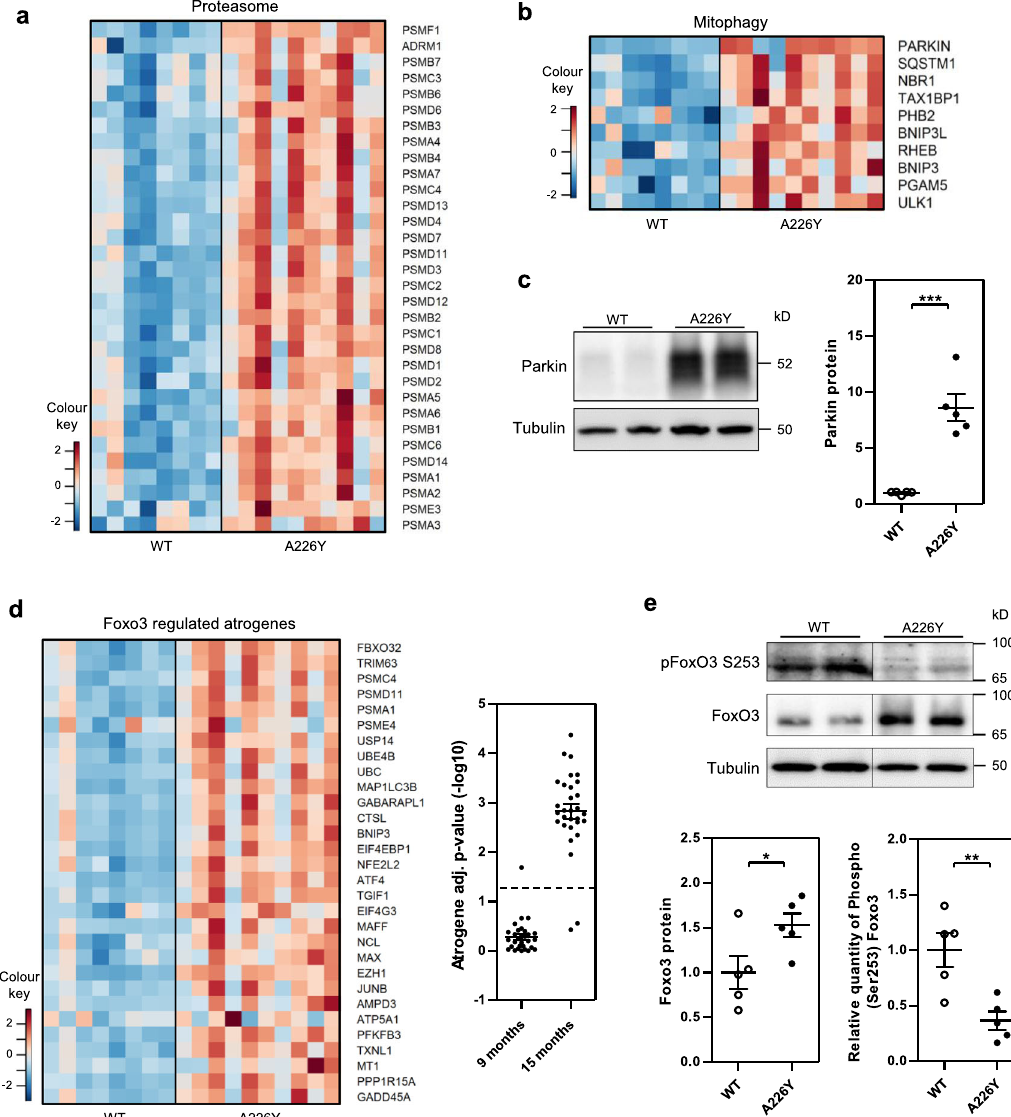
Fig. 3 Protein degradation pathways in the muscle of Rps2 A226Y mutant mice at 15 months of age. Graphs show mean, SEM and individual data points. *** p < 0.001, ** p < 0.01, * p < 0.05. a Heatmap representing the signi fi cantly upregulated genes ( p < 0.05) in the KEGG pathway ‘ Proteasome (mmu03050) ’ . b Heatmap representing the signi fi cantly upregulated genes (FDR < 0.05) involved in priming mitochondria for mitophagy 35 . c Western blot and densitometry of total Parkin content in A226Y vs WT ( N = 5). Tubulin as loading control. d Heatmap of Foxo3-regulated atrogenes 39 , and a plot of – log10 FDR adjusted p -values for each Foxo3-regulated atrogene ( N = 30) (A226Y vs WT) in 9 and 15 months mouse muscle. The dashed line indicates p = 0.05. e Western blot and densitometry of total and speci fi c phosphorylated Foxo3 protein ( N = 5). Tubulin as loading control. Relative quantity of phosphorylated protein calculated as phosphorylated/total. N = number of independent mice in each